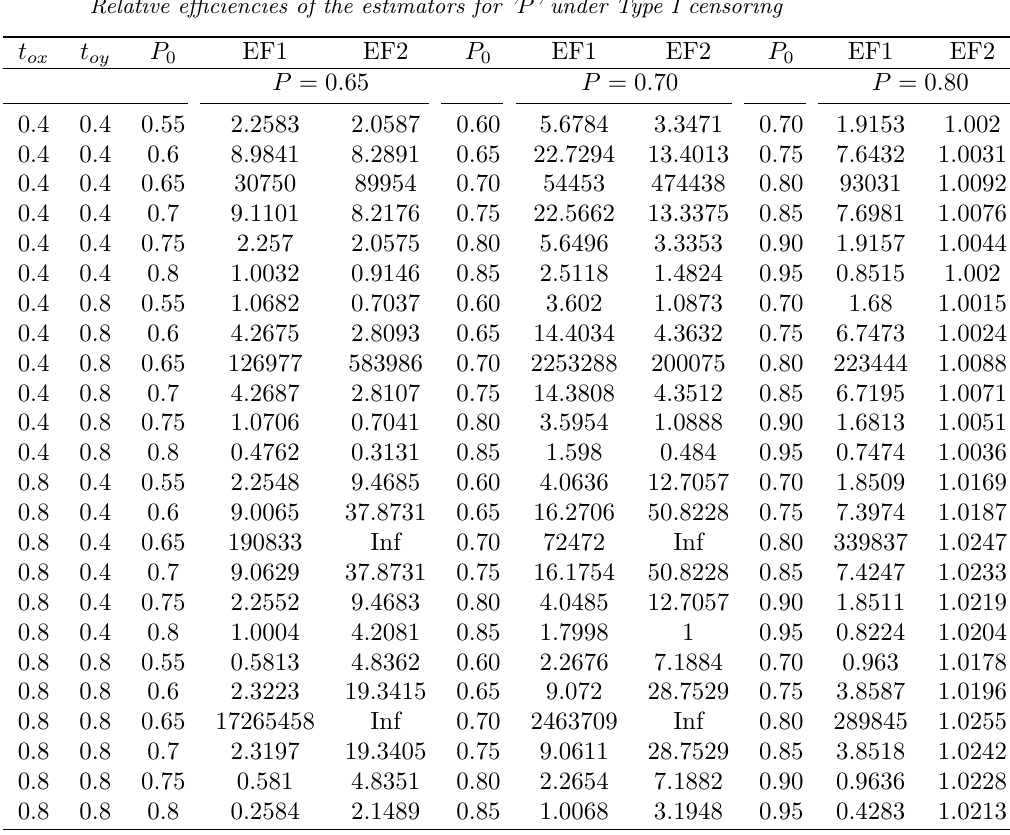
Relative efficiencies of the estimators for ’ P ’ under Type I